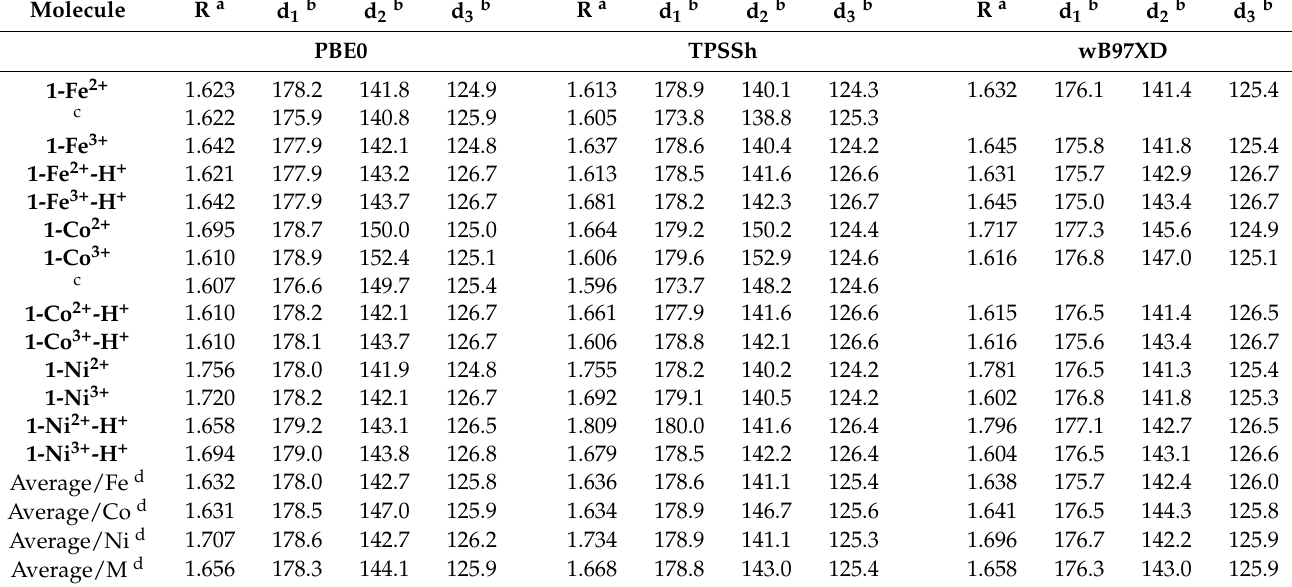
Table 1. Selected distances (Å) and dihedral angles (degrees) of the calculated structures at PBE0, TPSSh, and wB97XD/6-31G(d,p) in THF